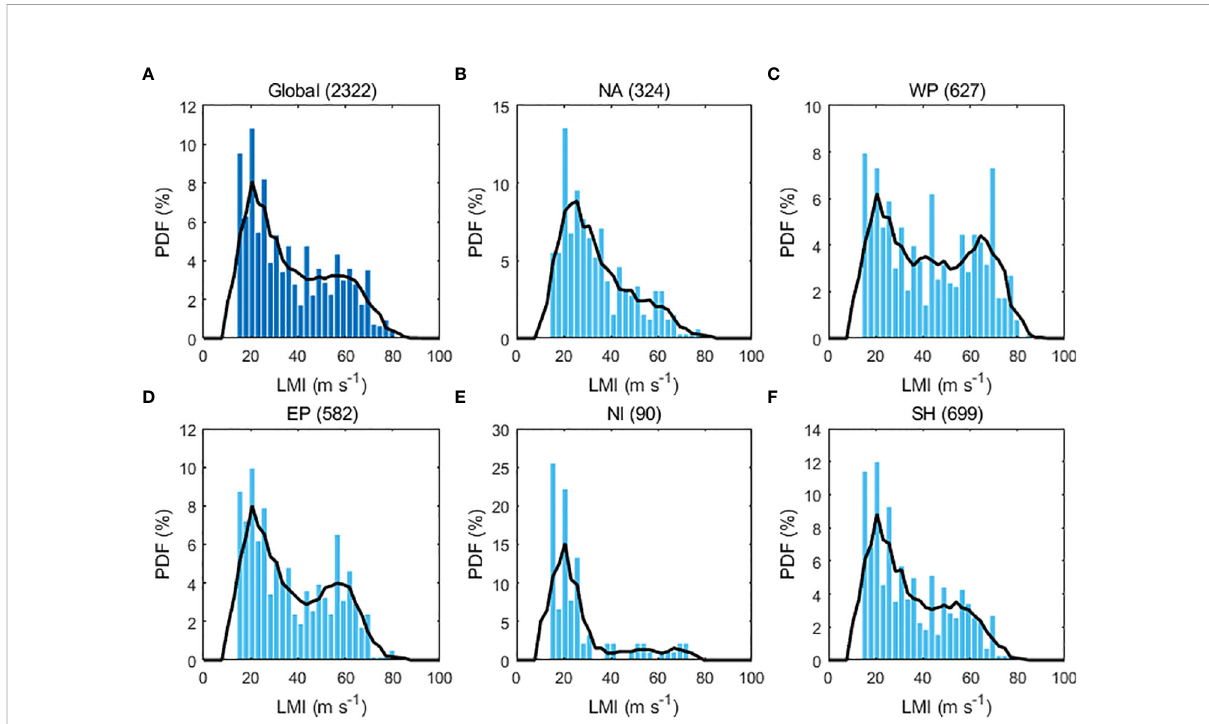
FIGURE 1 Distribution of tropical cyclone lifetime maximum intensity in 1982 – 2020: (A) Global, (B) North Atlantic, (C) Western Paci fi c, (D) Eastern Paci fi c, (E) North Indian Ocean, and (F) Southern Hemisphere. The blue bars show the raw data binned into 2.6 m s − 1 bins. The solid black lines indicate the smoothed probability density functions with a window width of 10.3 m s − 1 . The number of samples is indicated in parentheses. Only samples from 2001 – 2017 with a distance of 259 km (global mean of the radius of at least 17.5 m s − 1 winds + one standard deviation from land) were analyzed to exclude cases affected by topography. Short-lived tropical cyclones (two days or less at tropical storm-force intensity) were excluded to avoid data heterogeneity (Landsea et al.,